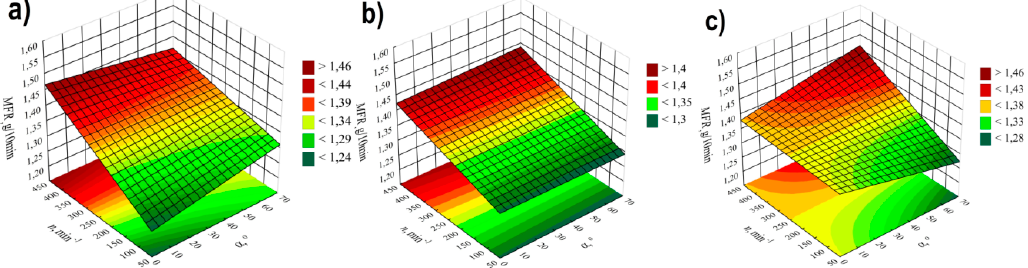
Figure 5. MFR response surface plots based on screw rotational speed n and angle of rotation of the kneading elements α with a talc content of ( a ) u = 10%; ( b ) u = 13%; ( c ) u = 16%.